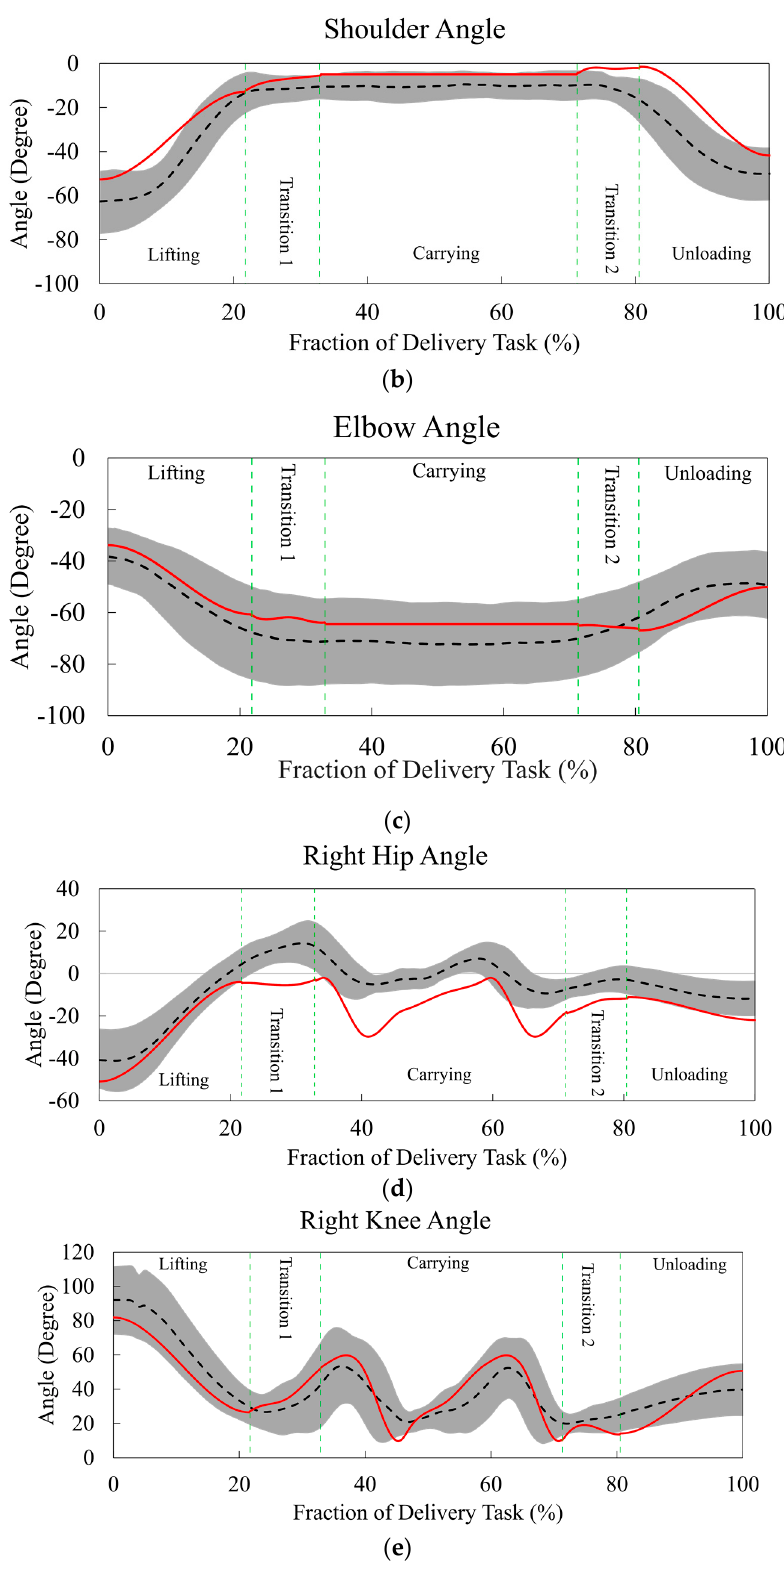
Figure 5. Joint angle profiles for deliver motion: ( a ) spine, ( b ) shoulder, ( c ) elbow, ( d ) right hip, and ( e ) right knee.